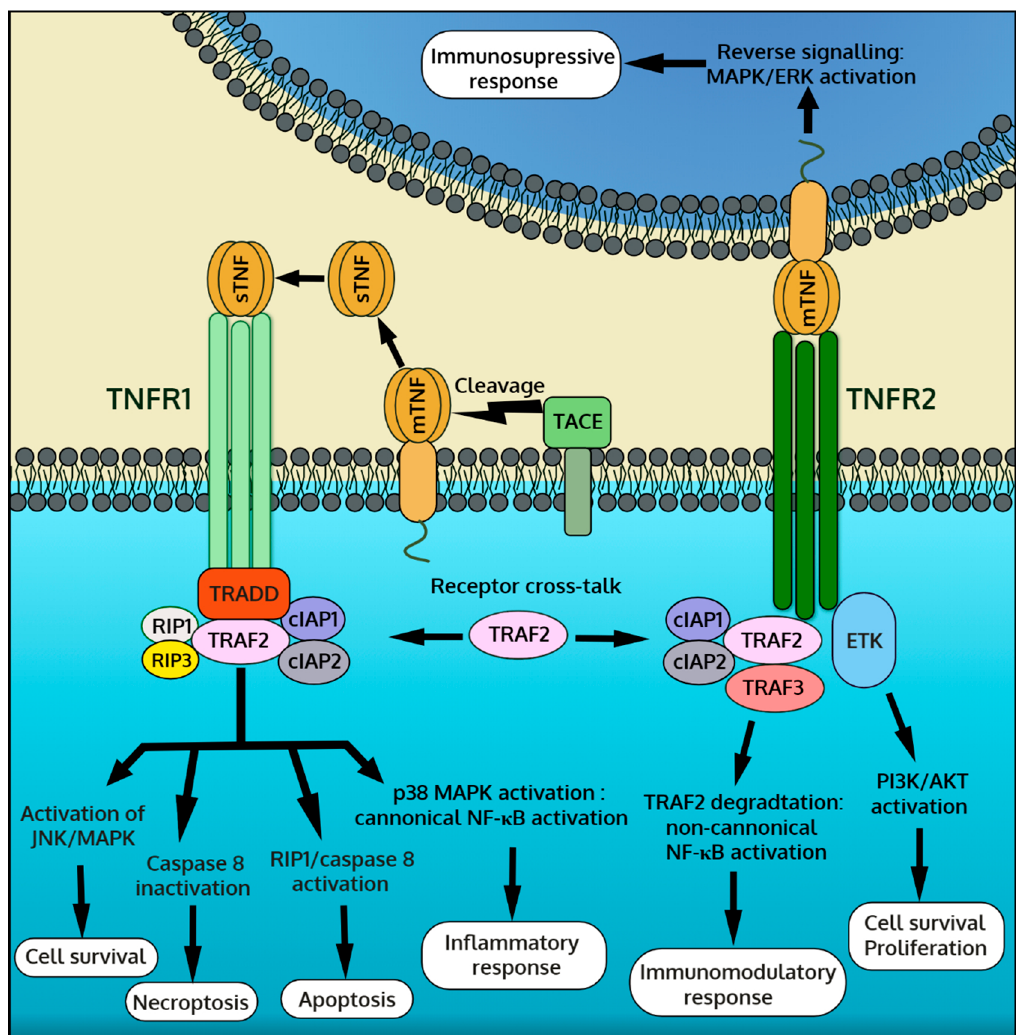
Figure 1. Overview of tumor necrosis factor- α (TNF- α ) downstream signaling pathway mediated by two TNF- α receptors, TNFR1 and TNFR2, and by membrane form of TNF- α (mTNF- α ) reverse